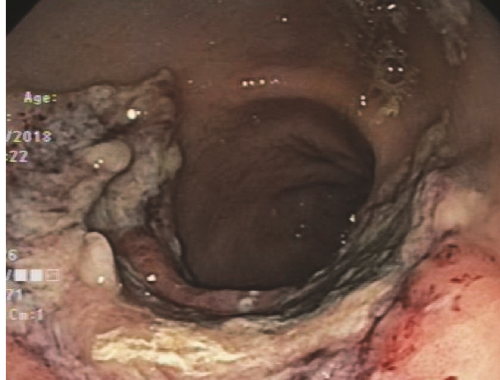
Figure 2: Endoscopic imaging of gastric lesion before the initiation of treatment.